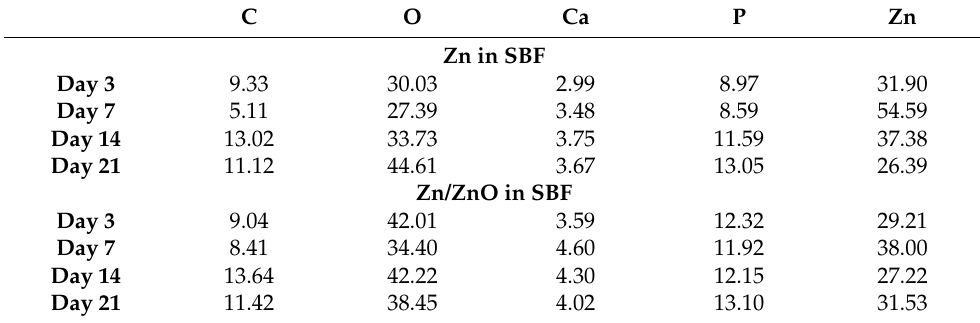
Figure 6. SEM micrographs of samples after immersion in SBF: ( a – d ) Zn in SBF for three days, seven days, 14 days, and 21 days; ( e – h ) Zn/ZnO in SBF for three days, seven days, 14 days, and 21 days. The scale bar for all images is 50 and 2 μ m for insert images. Table 2. EDS data for samples after different times of immersion in SBF (At.%).